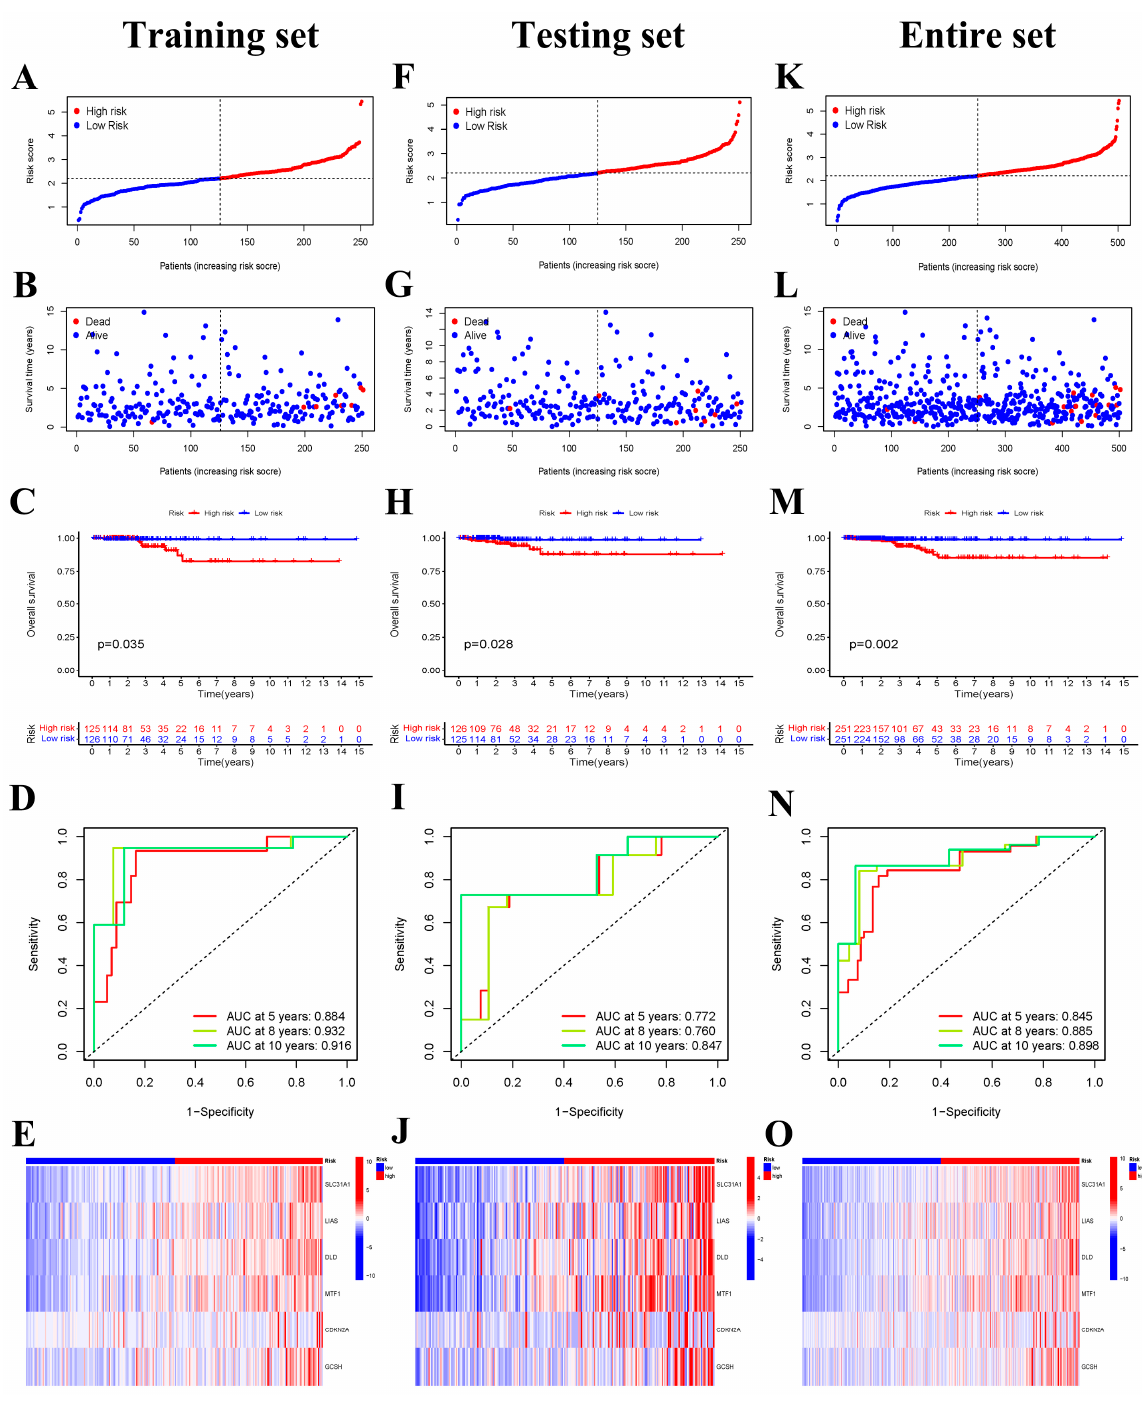
Figure 3. Identification of six cuproptosis-related genes prognostic signatures in the training set, the testing set, and the entire set. ( A ) The distribution of risk scores, ( B ) survival status, ( C ) Kaplan–Meier curve analysis of overall survival of THCA in low − and high − risk groups, ( D ) time-dependent ROC analysis, and ( E ) the expression of six prognostic CRGs in low- and high-risk groups in the training set. ( F ) The distribution of risk scores, ( G ) survival status, ( H ) Kaplan–Meier curve analysis of overall survival of THCA in low − and high − risk groups, ( I ) time − dependent ROC analysis, and ( J ) six-CRGs expression patterns in low- and high-risk groups in the testing set. ( K ) The distribution of risk scores, ( L ) survival status, ( M ) Kaplan–Meier curve analysis of overall survival of THCA in low − and high − risk groups, ( N ) time − dependent ROC analysis, and ( O ) six-CRGs expression patterns in low − and high − risk groups in the entire